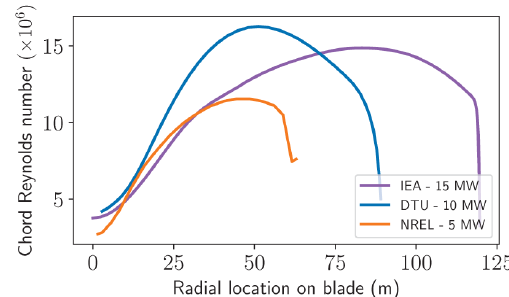
Figure 1. Variation of chord Reynolds number and airfoil thickness along the blade span for three modern, open-source, megawatt-scale turbines: NREL 5MW (Jonkman et al., 2009), DTU 10MW (Bak et al., 2013), and IEA 15MW (Gaertner et al.,